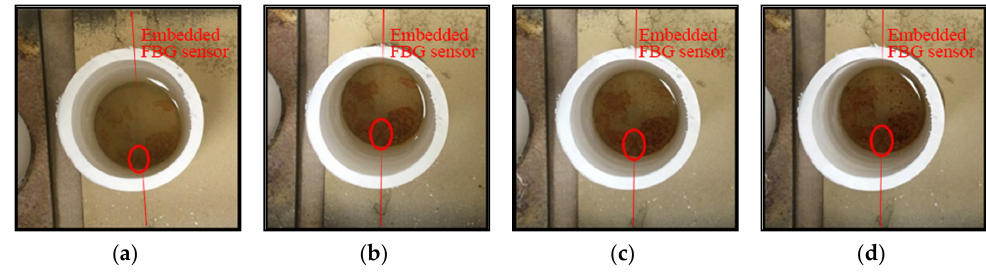
Figure 15. Visual inspections of Sample #2. ( a ) Day 1; ( b ) Day 2; ( c ) Day 3; ( d ) Day 6.